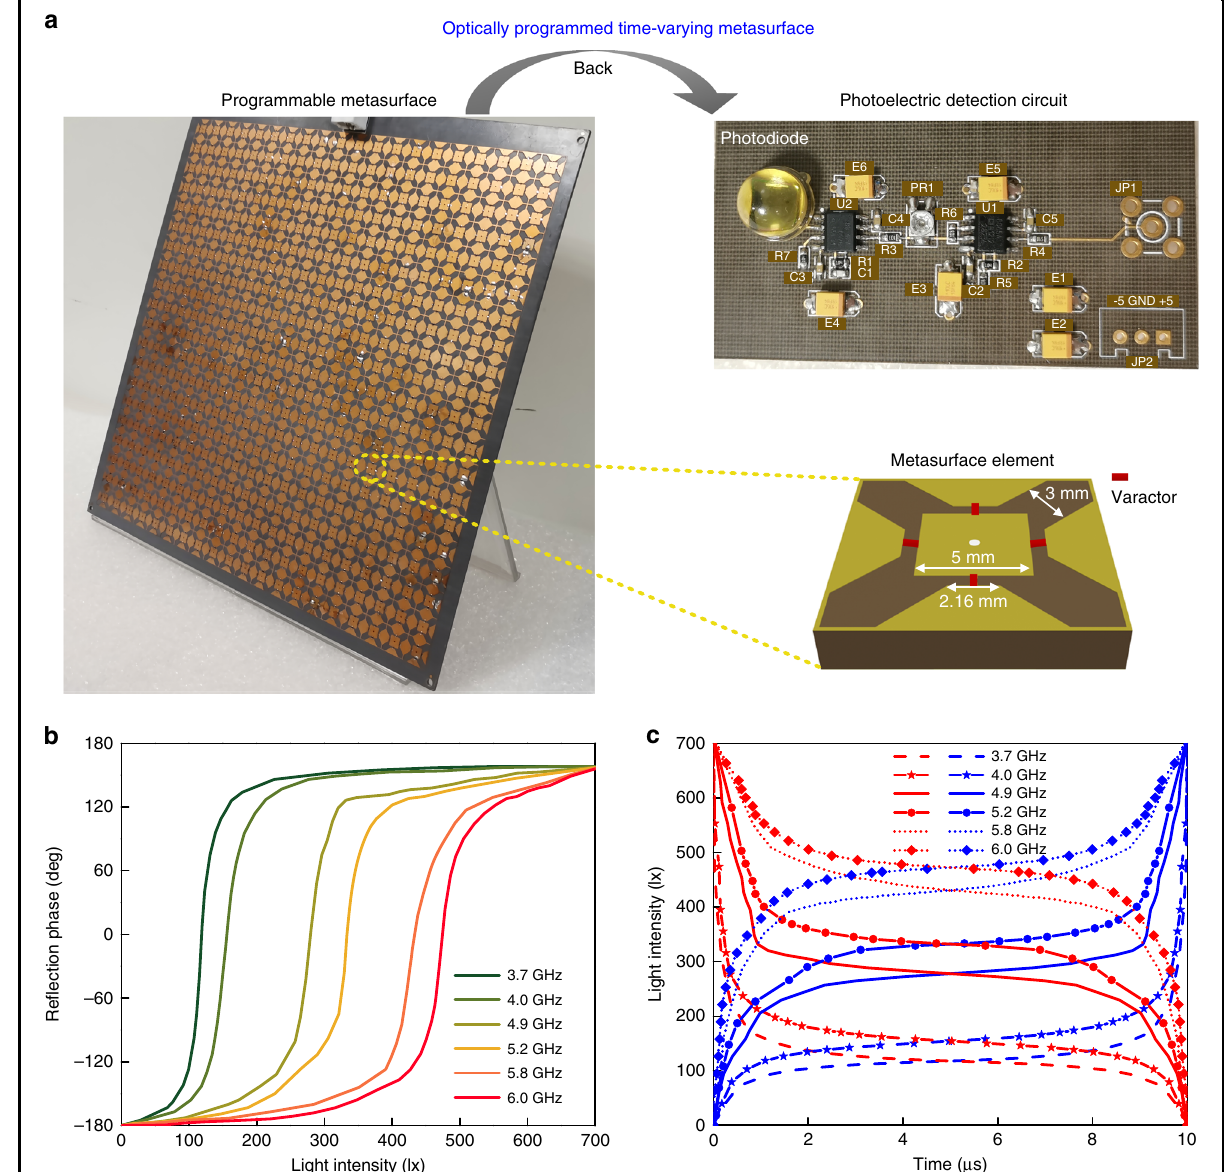
Fig. 2 The optically programmed time-varying metasurface and its performance. a Fabricated hybrid metasurface platform, in which a photoelectric detection circuit is integrated on the back of the programmable metasurface. In the metasurface element, four identical varactors are loaded onto the four 0.7-mm-width gaps of the top metal pattern, respectively. b Measured re fl ection phases of the metasurface sample under the x - polarized incidence at several frequencies for different light intensities varying from 0 to 700 lx. c Up-modulation light waveforms (blue curves) and down-modulation light waveforms (red curves) with 100 kHz modulation frequency for ef fi ciently generating the blue-shifted components and red- shifted components, respectively, at the corresponding